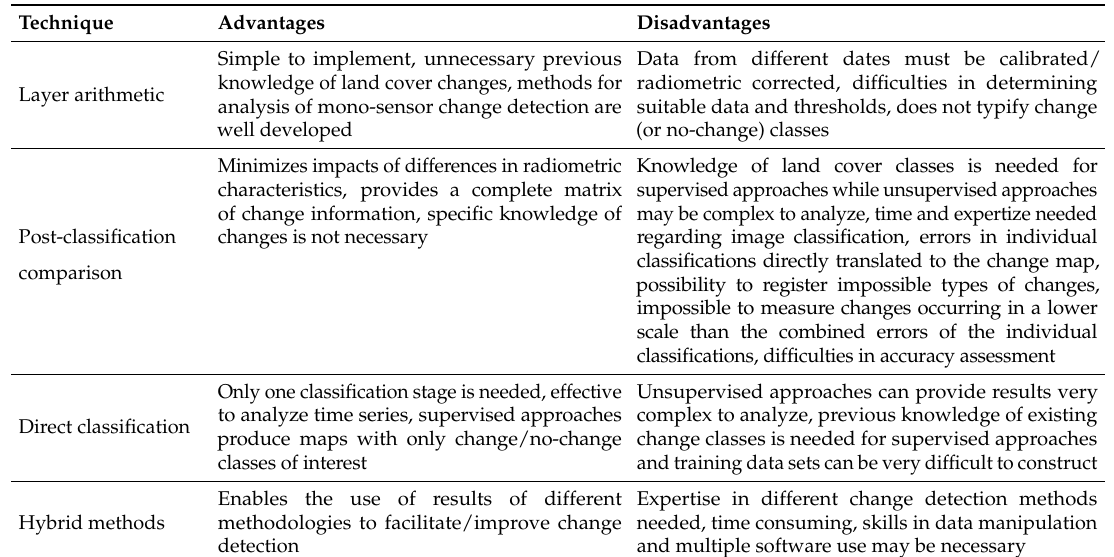
Table 2. Main characteristics of change detection